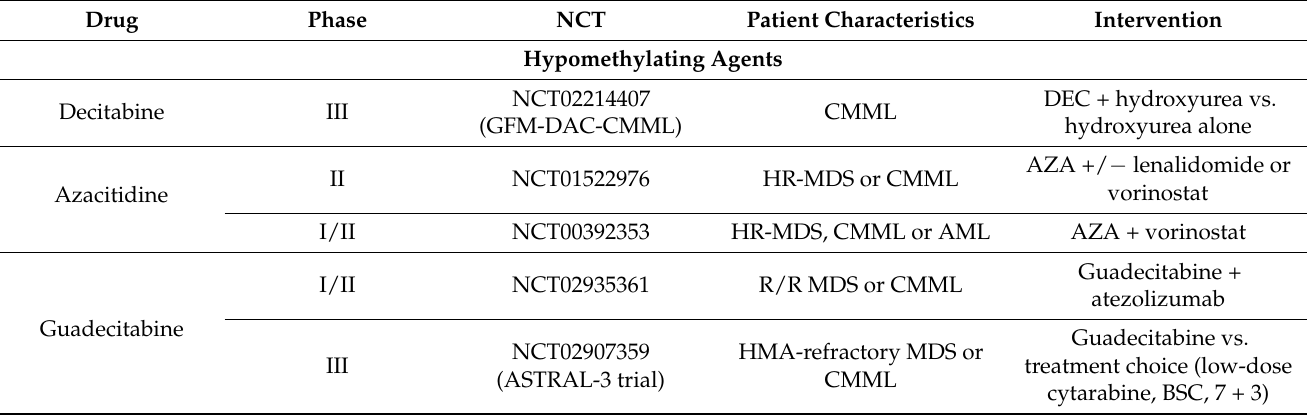
Table 1. Selected active phase II/III trials of novel agents in MDS and CMML.